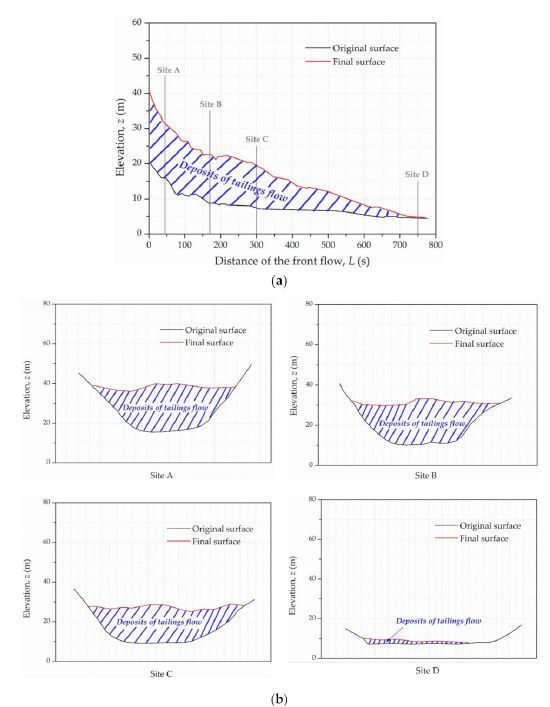
Figure 9. Numerical results of the Dagangding tailing flow: ( a ) final profile; ( b ) cross sections of four typical